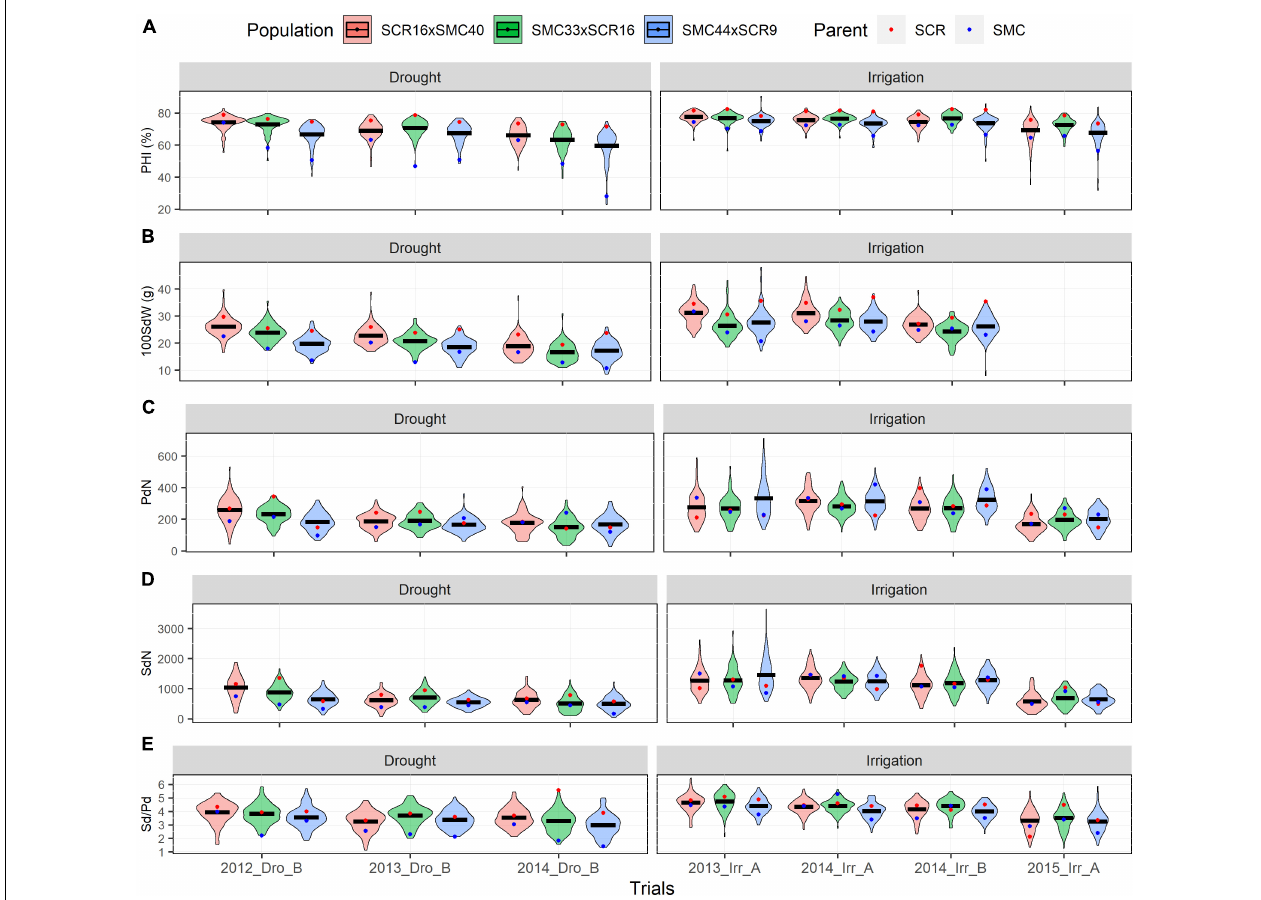
FIGURE 2 | Phenotypic distribution of agronomics traits. Pod harvest index (PHI) (A) , 100 seed weight (100SdW) (B) , pod number (PdN) (C) , seed number (SdN) (D) , seed per pod (Sd/Pd), and (E) evaluated of 2012, 2013, 2014, and 2015 under drought and irrigated conditions for the SCR16 × SMC40, SMC33 × SCR16, and SMC44 × SCR9